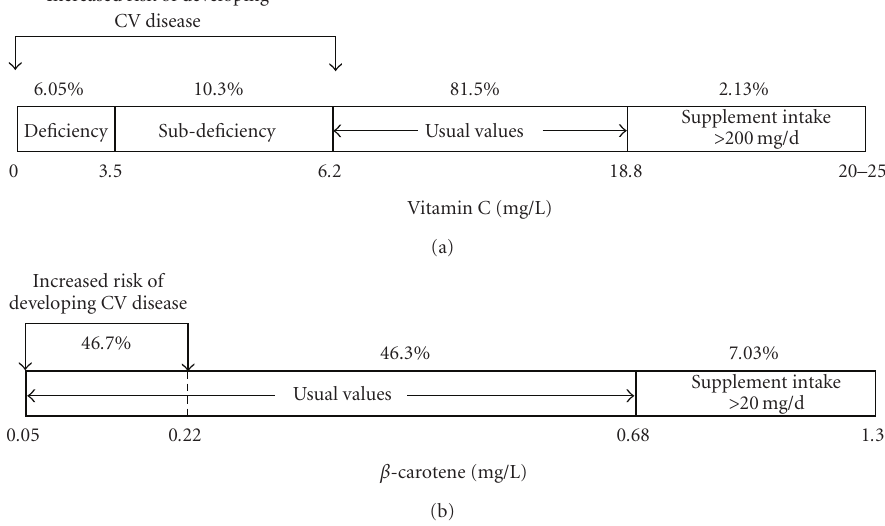
Figure 1: Plasma vitamin C and β -carotene distribution in the whole ELAN cohort ( n = 897) with respect to usual values and the critical cuto ff values of 6 mg/L (34.2 μ M) for vitamin C and 0.22mg/L (0.4 μ M) for β -carotene. Usual (or reference) values were established on a population of 128 healthy volunteers and published earlier